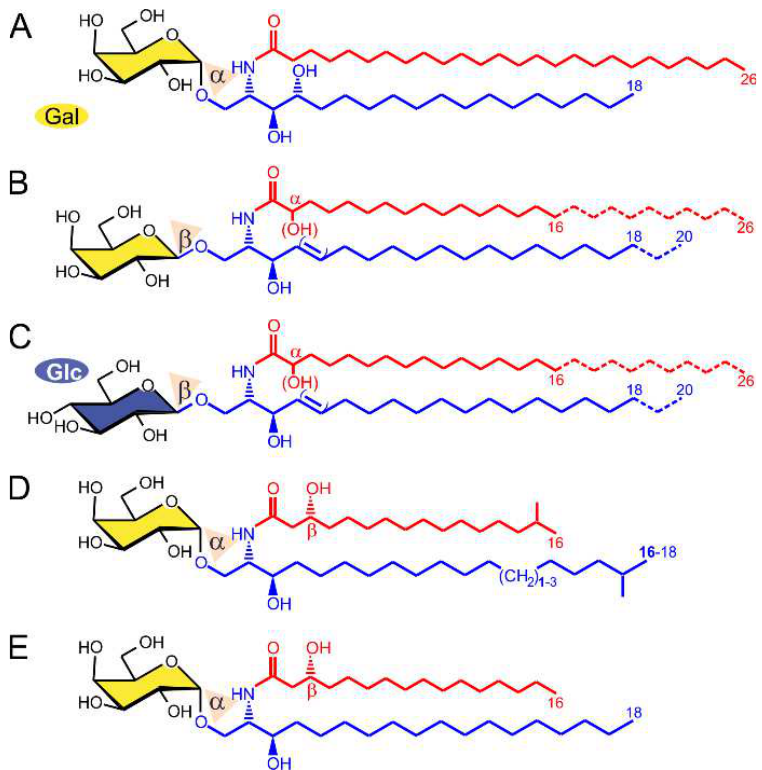
Figure 1. Structures of immunogenic α -GalCer and mammalian β -hexosylceramides. The α -GalCer KRN7000 is a synthetic glycolipid similar to galactosylceramides isolated from the marine sponge Agelas mauritianus ( A ). α -GalCer is a strong immunostimulant and shows potent anti-tumor activity in many in vivo models. Humans can produce only the beta-anomeric form of GalCer ( B ), as well as that of glucosylceramide (GlcCer) ( C ), both of which cannot stimulate iNKT cells. Commensal human bacteria can produce a α -GalCer with a shorter ceramide anchor compared to KRN7000. The ceramide anchor consists of an iso-branched sphinganine and an iso-branched beta-hydroxy acyl chain ( D ). Bacteria of the mouse gut can also produce α -GalCer similar to that in humans, but without iso-branching of the sphinganine or acyl chain ( E ). Chain length variations are drawn with dotted lines, while functional groups, which are not necessarily present, are set in